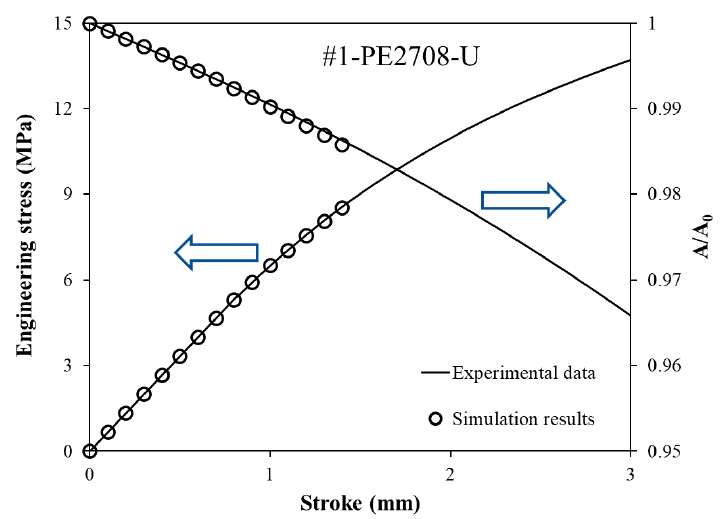
Figure 5. The engineering stress–stroke curves of the six PE pipes. (The red solid triangles mark the peak stress.)